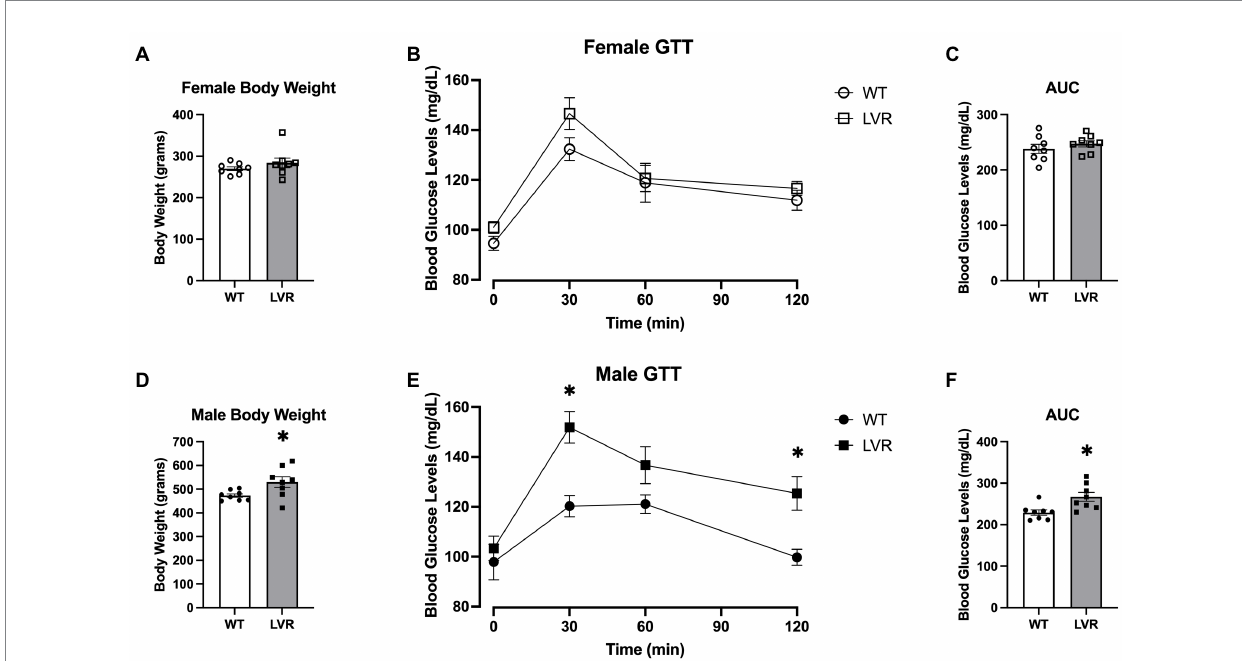
FIGURE 6 Male LVR display deficits in glucose uptake and increased bodyweight. (A) Bodyweight of 4-month-old female WT and LVR ( N = 8). (B) Glucose tolerance testing results in female WT and LVR. (C) Area under the curve analysis of glucose tolerance testing in females. (D) Bodyweight in male WT and LVR ( N = 8) evaluated by Student’s t -test. (E) Glucose tolerance testing results in male WT and LVR evaluated by RM 2-way ANOVA. (F) Area under the curve analysis of glucose tolerance testing in males evaluated by Student’s t -test. * Denotes significant difference between groups. Values expressed as mean +